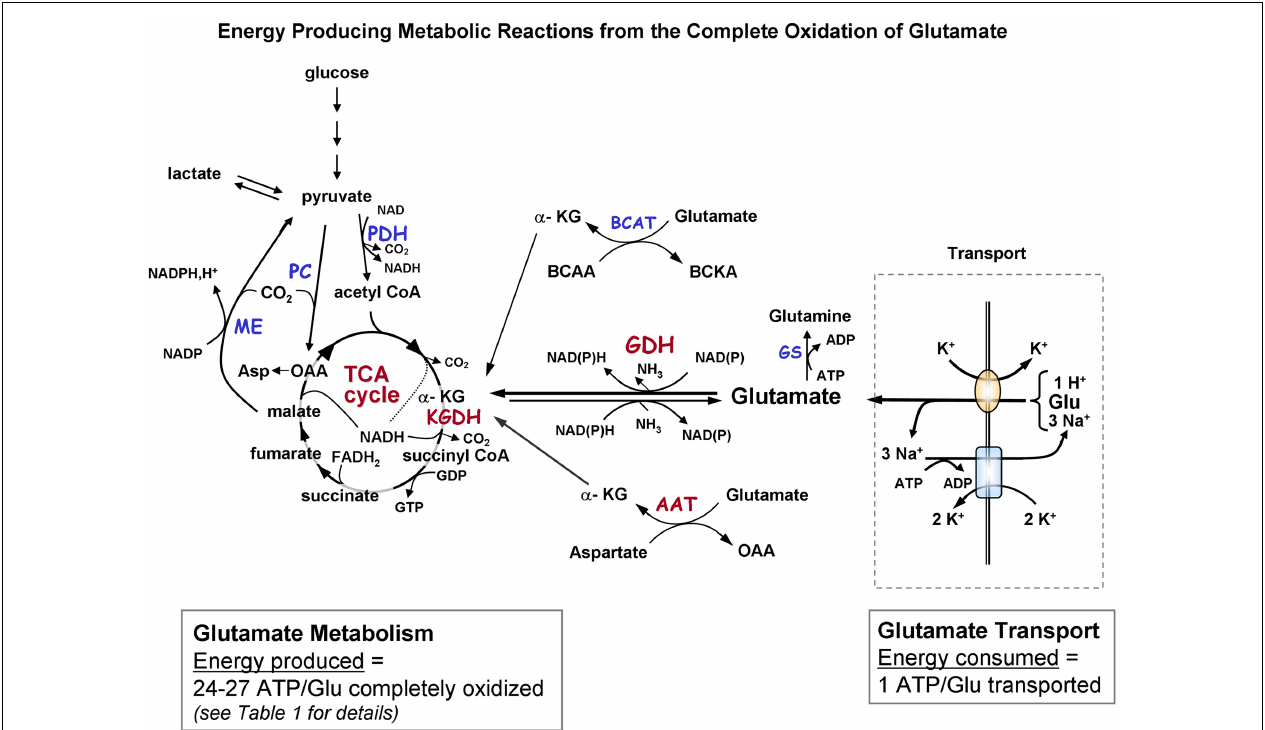
the acetyl CoA formed from the pyruvate recycling pathway is metabolized via theTCA cycle because the initial entry of carbons α -KG at is subsequent to this step.The complete oxidation of one glutamate molecule can yield 24–27 ATP depending on whether the initial step in metabolism is via GDH or AAT.The ATP is estimated at ∼ 20 since the maximum theoretical yield of ATP is never recovered due to mitochondrial proton leak. [See Table 1 for reaction details and (B) for labeling pattern of metabolites labeled from the initial metabolism of [U- 13 C]glutamate and the labeling pattern from subsequent metabolism via the pyruvate recycling pathway and re-entry into theTCA cycle]. Abbreviations: Glu, glutamate; α -KG, α -ketoglutarate OAA, oxaloacetate; Asp, aspartate; GDH, glutamate dehydrogenase; AAT aspartate aminotransferase; BCAT, branched-chain aminotransferase; ALAT, alanine aminotransferase; KGDH, α -ketoglutarate dehydrogenase; ME, malic enzyme; PDH, pyruvate dehydrogenase; GS, glutamine synthetase. BCAA, branched chain amino acid; BCKA, branched chain